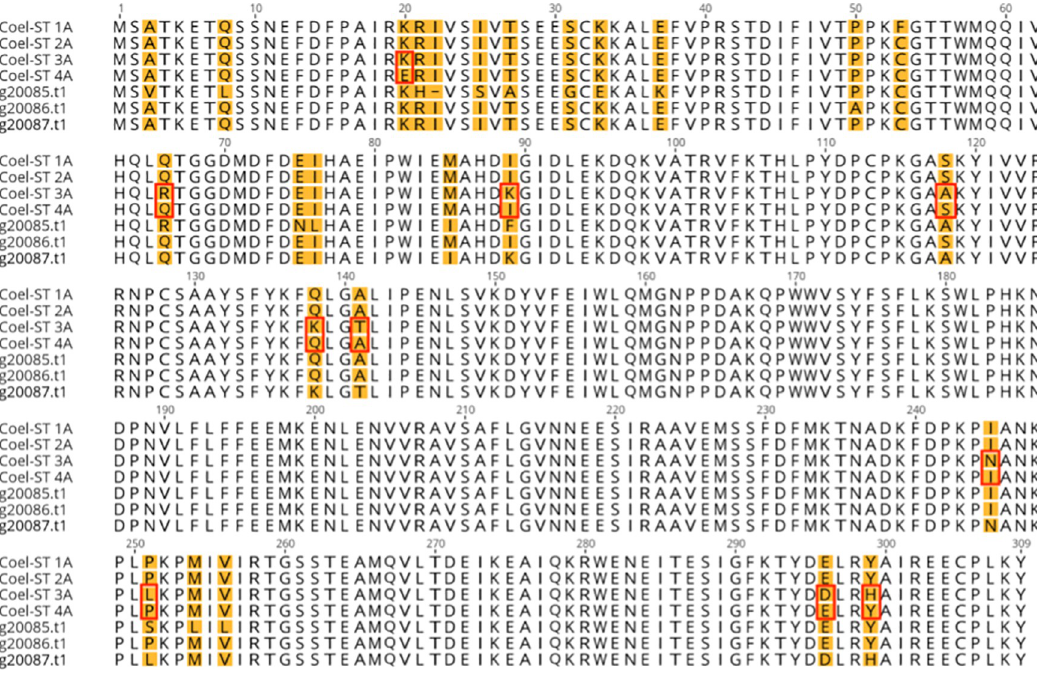
Fig 7. Alignment of the four Coel-ST isoforms, 1A, 2A, 3A and 4A, along with the 3 most closely related predicted proteins g20085.t1, g20086.t1, g20087.t1 from Jiang et al . 2019 [23]. The positions that vary among all seven ORFs are highlighted in yellow. The residues that vary between Coel-ST 3A and 4A are outlined in